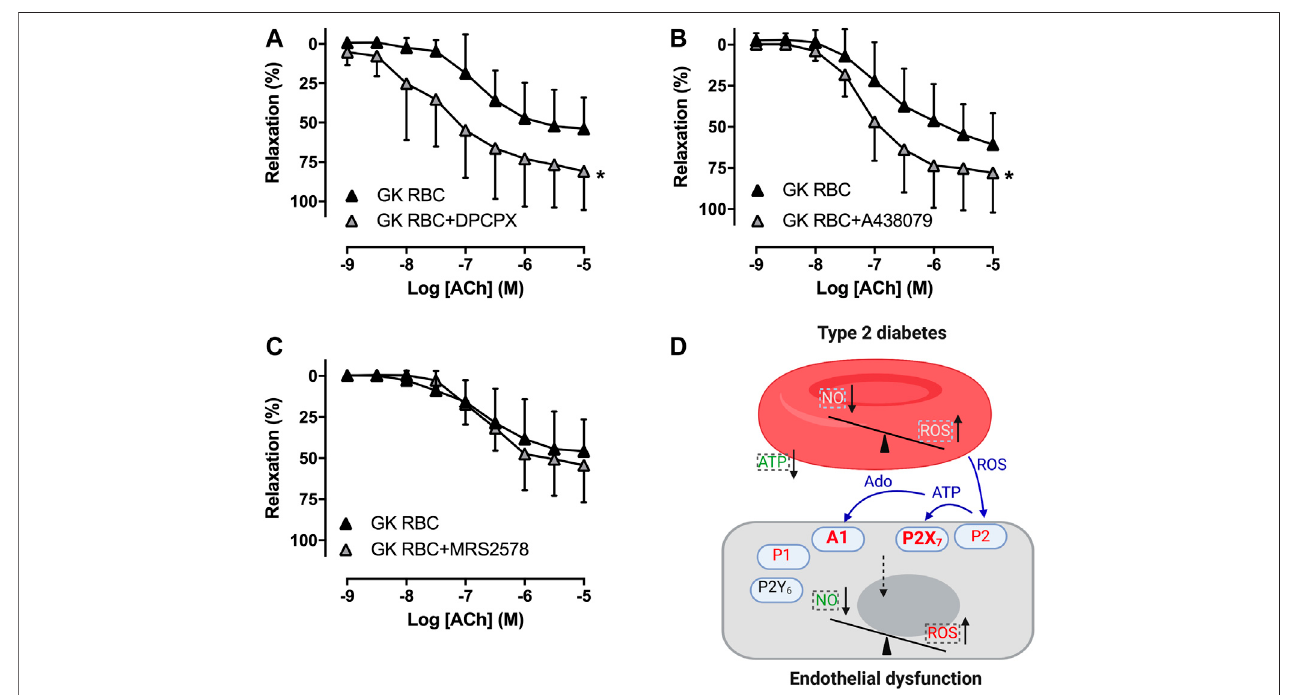
FIGURE 3 | Effect of purinergic receptor inhibition on endothelialfunction of aortas in recipient rats transfused with rat RBCs. Effect of the A1R antagonist DPCPX, theP2X 7 RantagonistA438079 andtheP2Y 6 RantagonistMRS2578onEDRinaortasofratstransfused withGKRBC( A :n (cid:1) 6, B :n (cid:1) 8, C :n (cid:1) 6).Schematicsummary ofthepresentstudy (D) :DysfunctionalRBCsofT2DaltervascularA1RandP2X 7 RbutnotP2Y 6 Raccountingforendothelialdysfunction.Dashedboxesrepresentearlier fi ndings where there are decreased nitric oxide (NO) bioavailability, increased reactive oxygen species (ROS) formation/release and impaired release of ATP from RBCs of T2D that break the balance between NO bioavailability and ROS in the endothelium (Pernow et al., 2019). Signaling in blue color represents the hypothesized mechanisms that the increased formation ofROSderived from RBCs may stimulate ATP release in other (endothelial) cells than RBCs toactivate P2X 7 Rin endothelium. Together with the subsequent degradation product adenosine, vasoconstrictor A1R and P2X 7 R are activated in T2D accounting for endothelial dysfunction. Values are mean ± SD. * p < 0.05 effect of antagonist. Ado: adenosine.